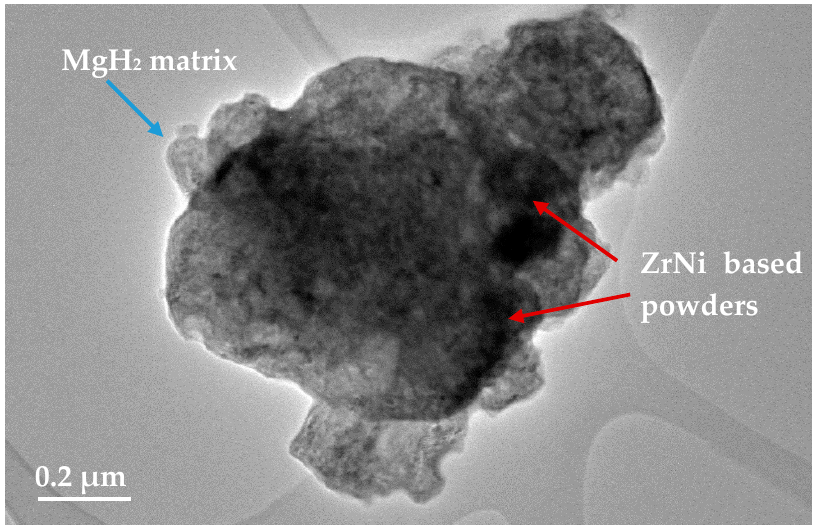
Figure 10. TEM of the bright field image of MgH 2 powders milled with 10 wt.% Zr (x) Ni (y) , demonstrating the agglomeration of catalyst on the surface of the MgH 2 matrix after 5 h milling time.